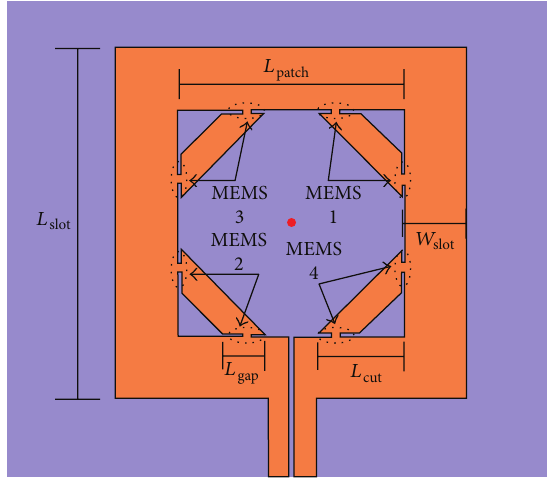
Figure 5: Frequency and polarization agile patch antenna